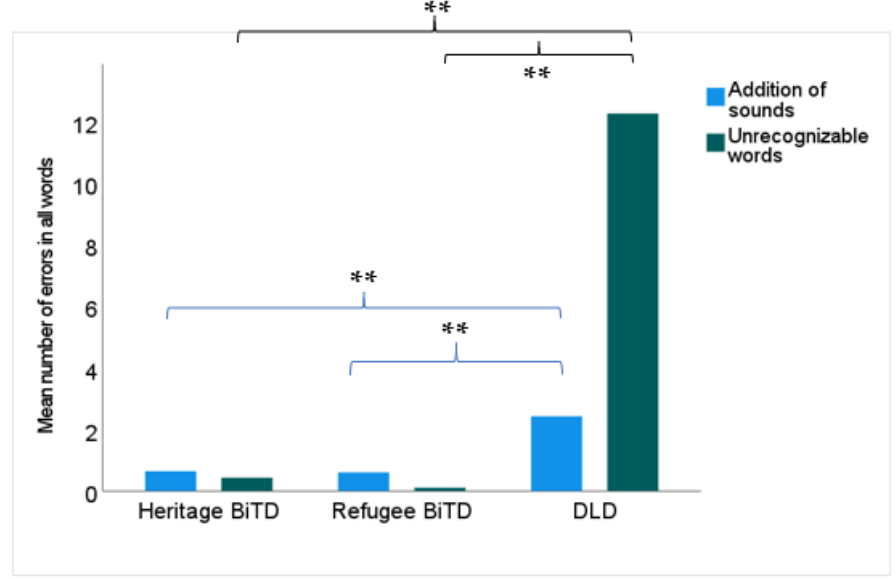
Figure 3. Qualitative analysis of subtest reading accuracy. ** Significance level < 0.01.